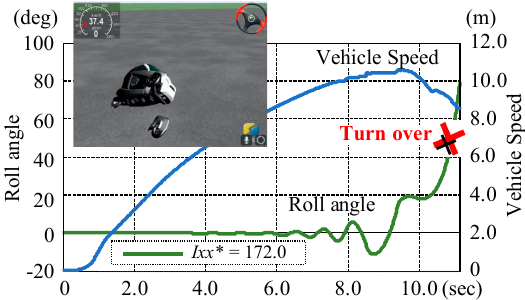
Figure 7. Turning over with too high roll moment of inertia of sprung mass ( Ixx *).